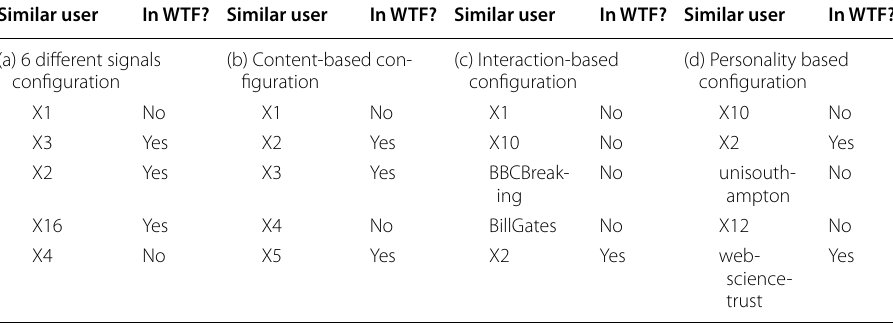
Table 8 Comparison between top 5 similar users and WTF Similar user In WTF? Similar user In WTF? Similar user In WTF? Similar